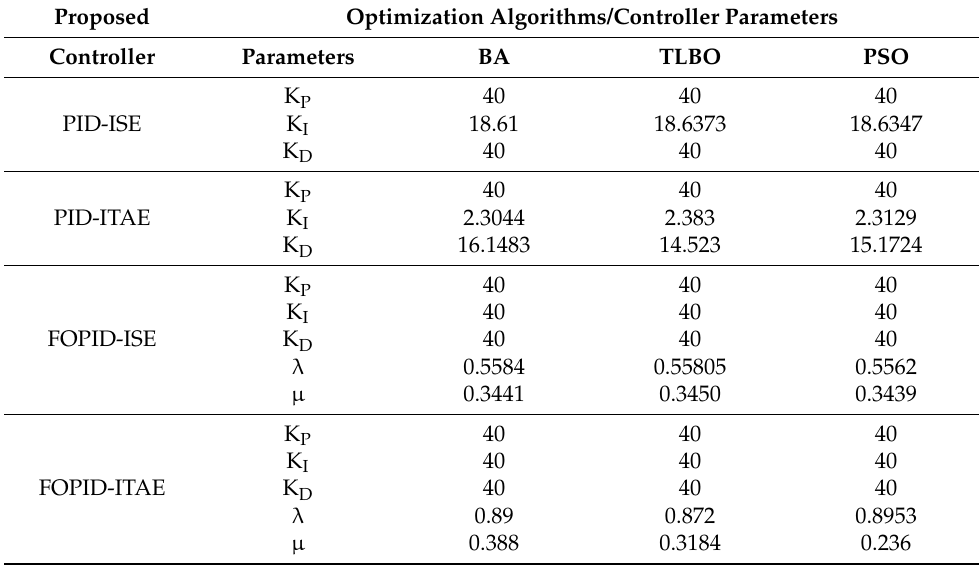
Table 6. Optimal gains of PID and FOPID with different algorithms for GB power